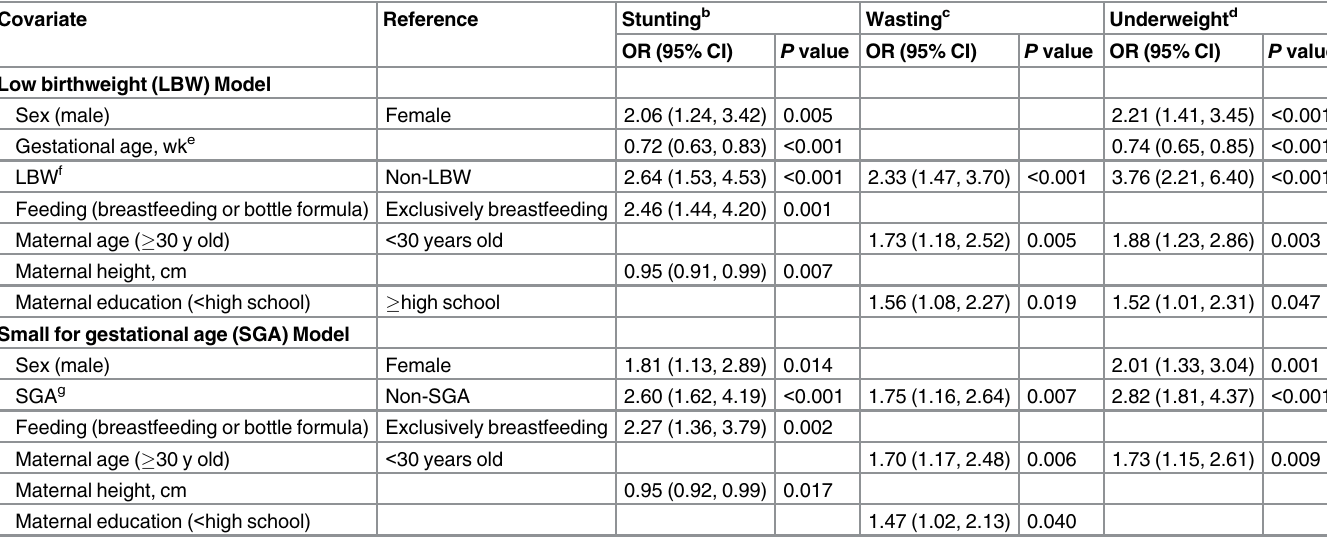
Table 3. Multivariable generalized estimating equations models predicting stunting, wasting and underweight during infancy a